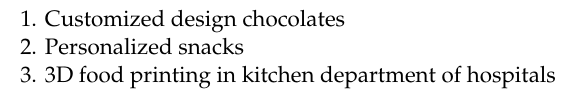
Table 7. Three business models generated in the development